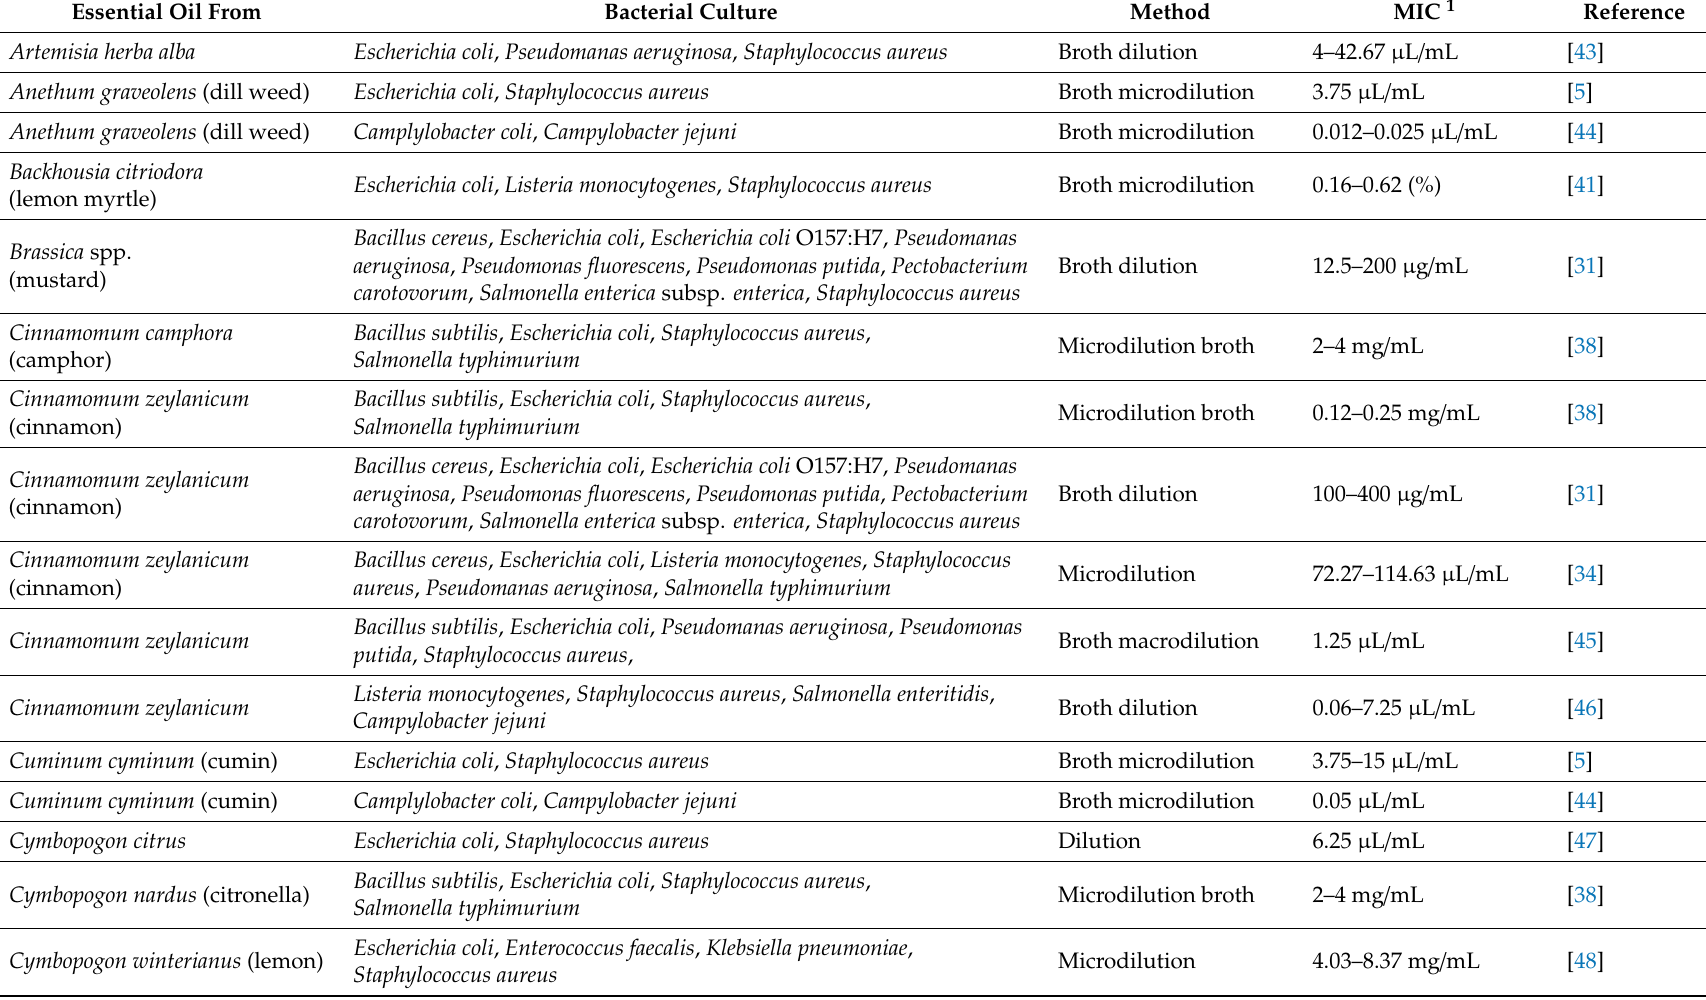
Table 1. Overview of studies about antibacterial properties of essential